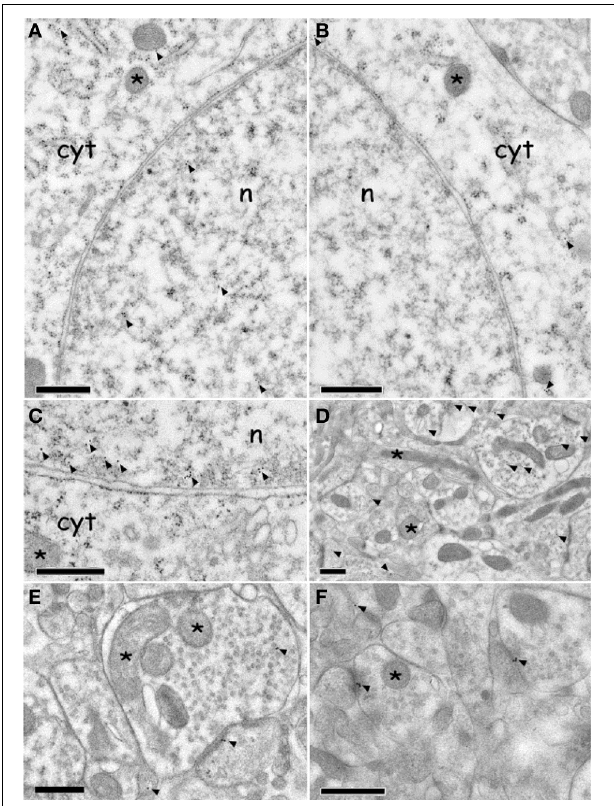
FIGURE 6 | Immuno electron microscopy localization of ERK and p-ERK inside the AcbSh neurons of (CS + -US + ) rats (Expr2). (A,C): p-ERK immunolabeling in neuron cell body nucleus and cytoplasm (arrowheads). The asterisks indicate mitochondria. (B): ERK immunolabeling in neuron cell body cytoplasm (arrowheads). The asterisks indicate mitochondria. (D–F): p-ERK immunolabeling in dendrites, dendritic spines, and pre-synaptic boutons (arrowheads). Asterisks indicate mitochondria. Abbreviations: cyt, cytoplasm; n, nucleus. Scale bars are 0.5 µ m.